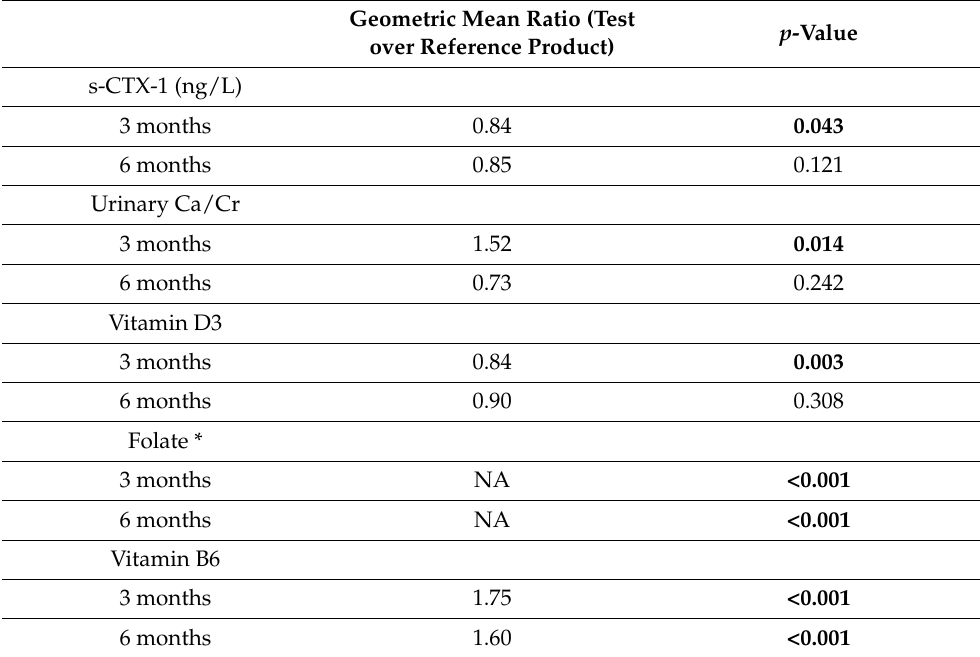
Table 4. Post-hoc tests for primary and secondary efficacy results that had deviations from the assumption of normality.